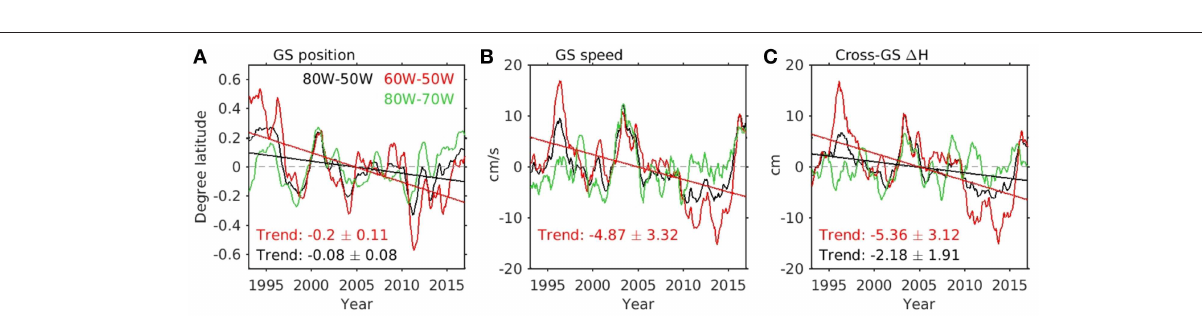
Frontiers in Marine Science |